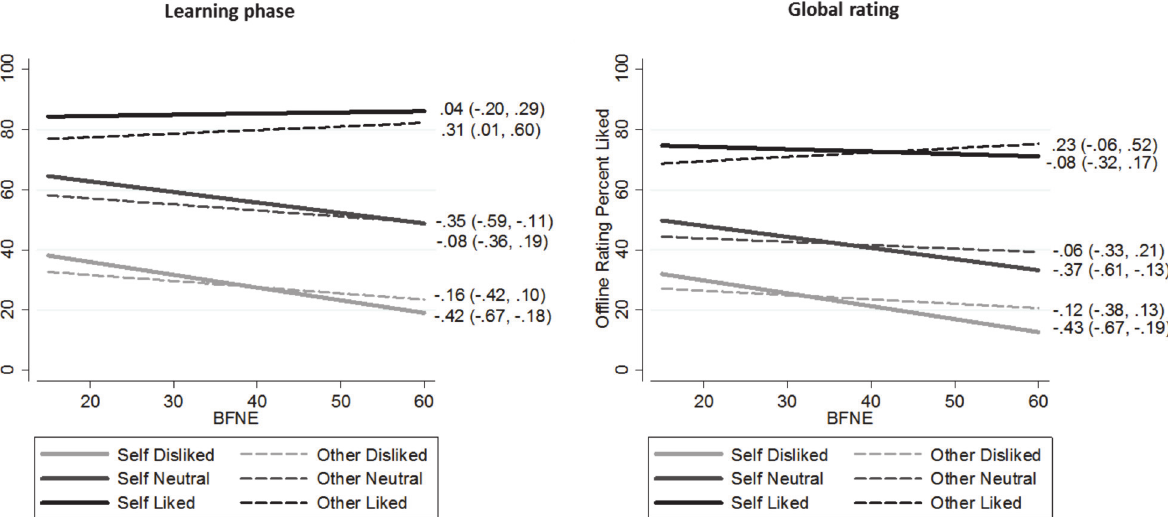
Fig 3. Predicted values for learning phase and global interpretations from regression models testing for differential effects of condition and rule on FNE. BFNE = Brief Fear of Negative Evaluation Scale. Rule contingencies like 80%, neutral 50%, dislike 20%. All regression models were a good fit for the data, each explaining around 64% of overall variance for the learning phase, and around 60% for the global ratings. We predicted the linear relationship between each rule and condition with social anxiety (coefficient and 95% confidence intervals) using the lincom command in Stata. These indicate that learning in the self-referential condition and in the neutral and disliked rules is most associated with FNE, and this holds for both the learning and global rating phases.